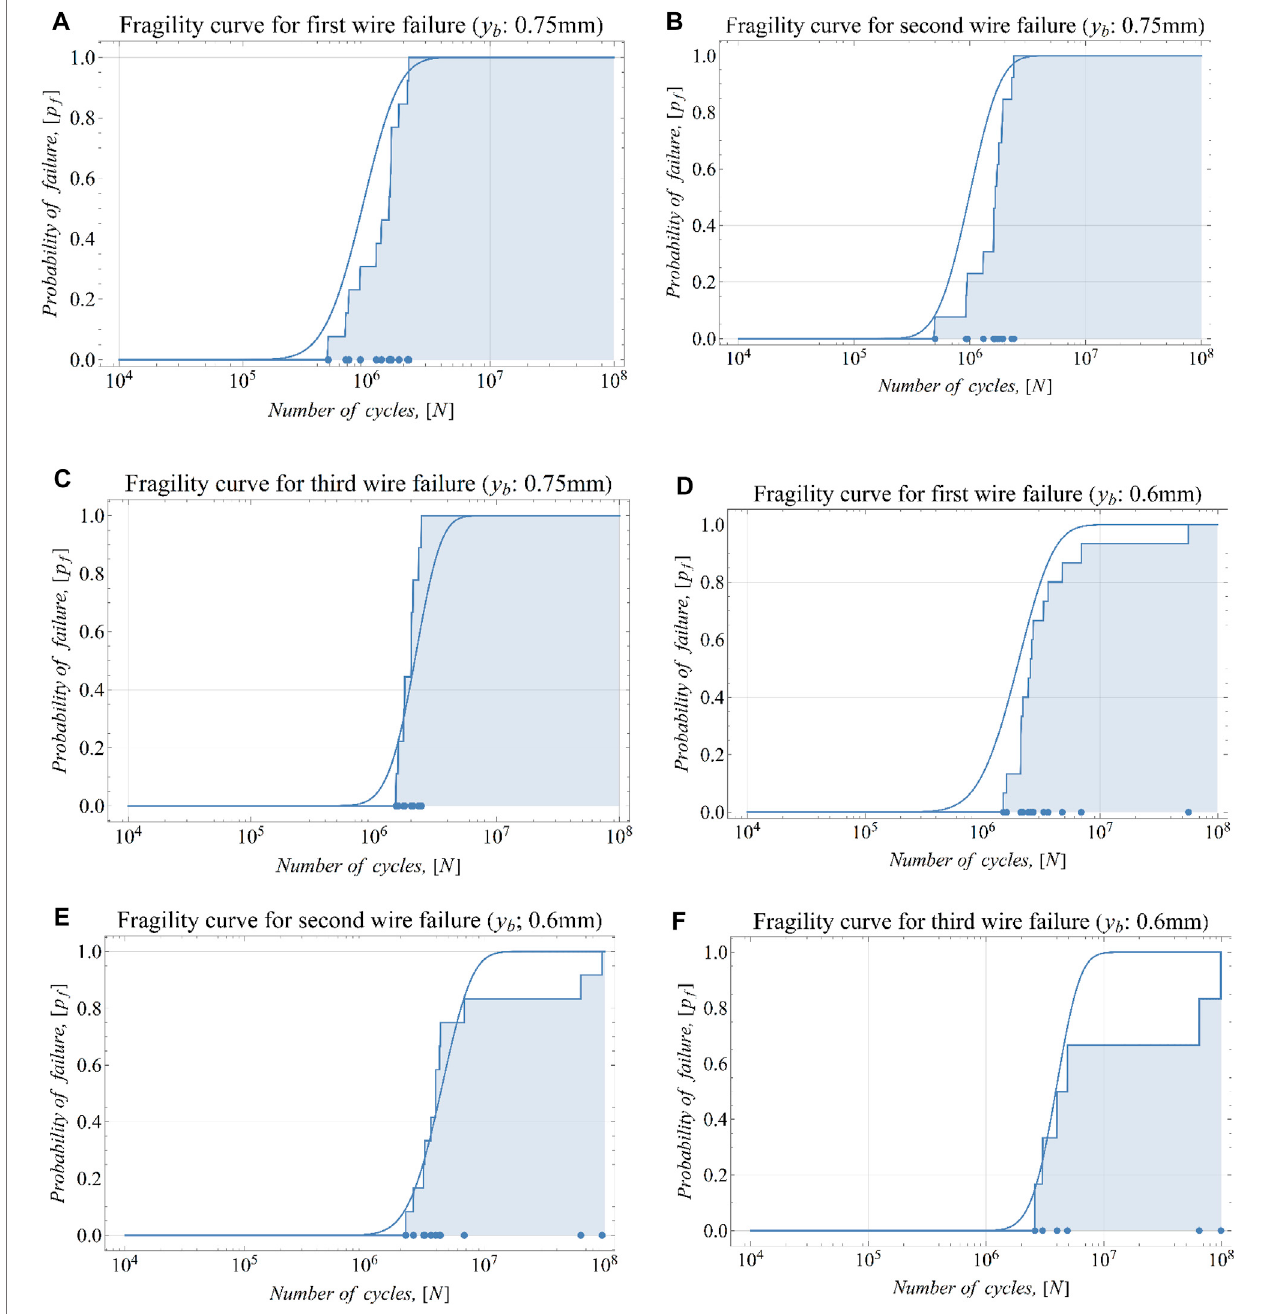
FIGURE 15 | Fragility curves for the Bersfort conductor-clamp assembly. (A – C) Bending amplitude of 0.75 mm. (D – F) Bending amplitude of 0.6 mm.